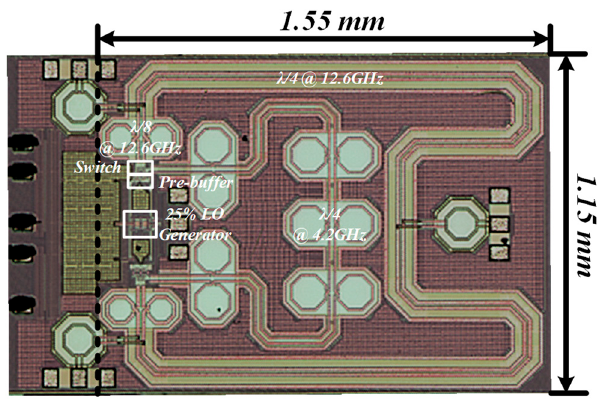
Figure 8. Die photo.